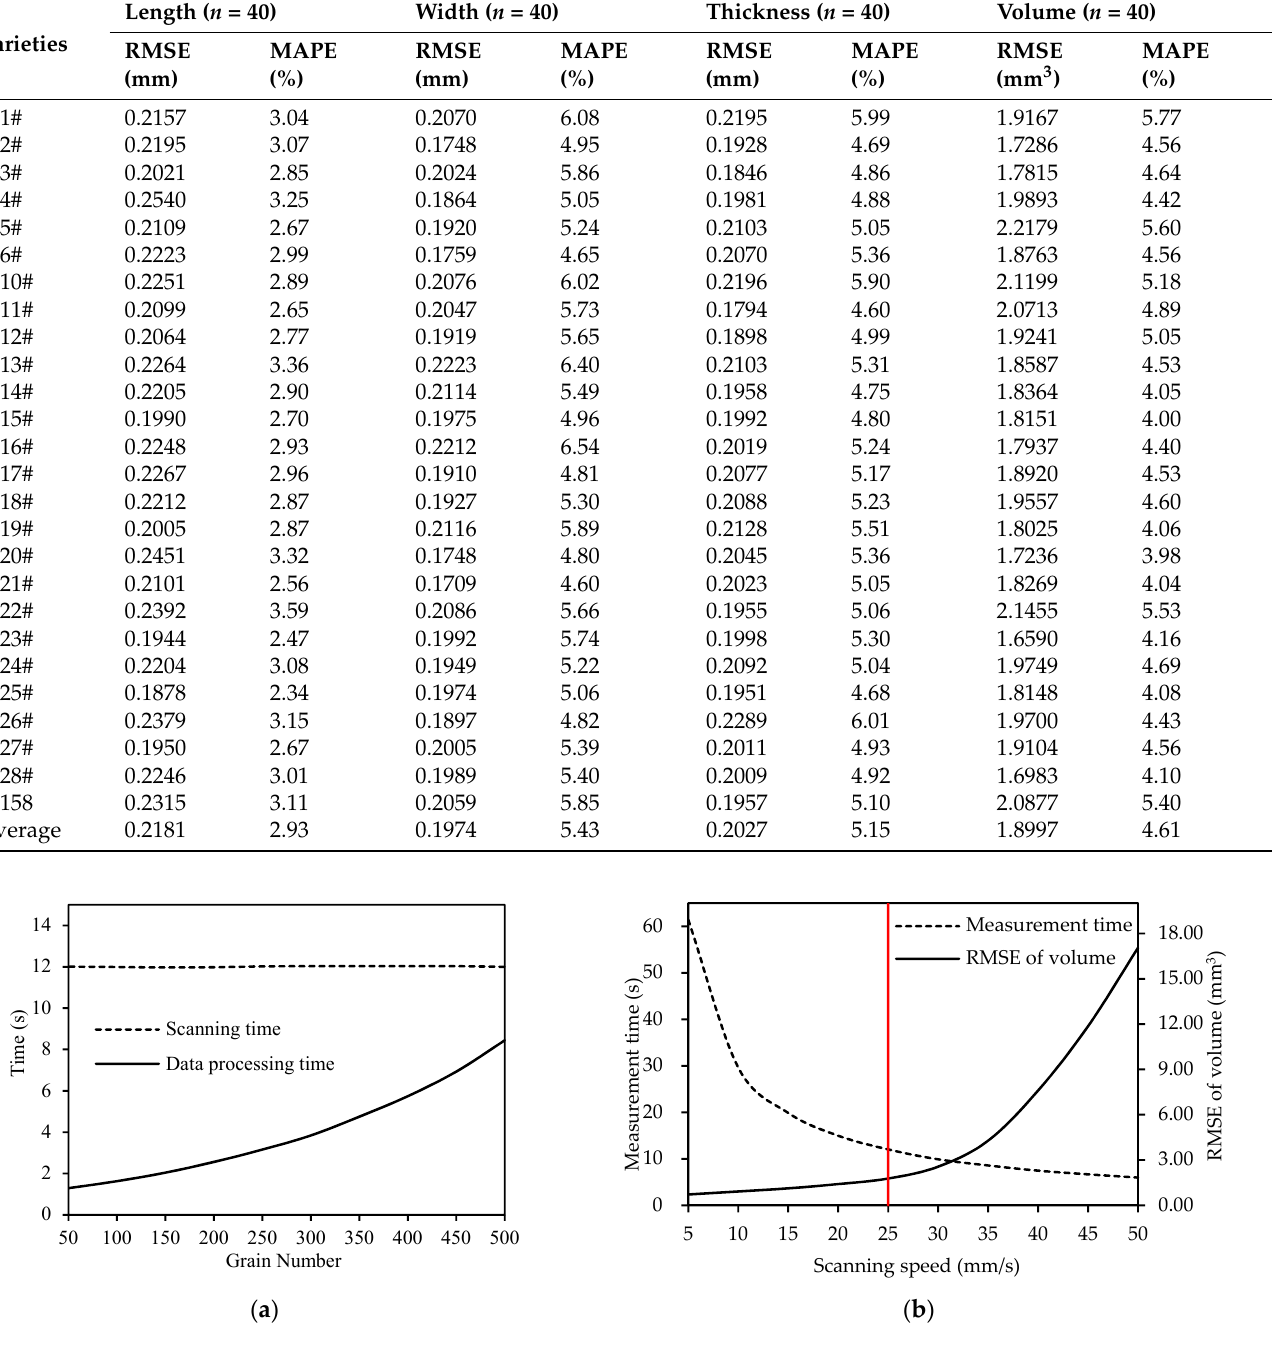
Figure 11. Measurement efficiency: ( a ) measurement time consumption for different numbers of grains; ( b ) relationship between scanning speed and measurement time and RMSE of volume. The red line is selected reference line.